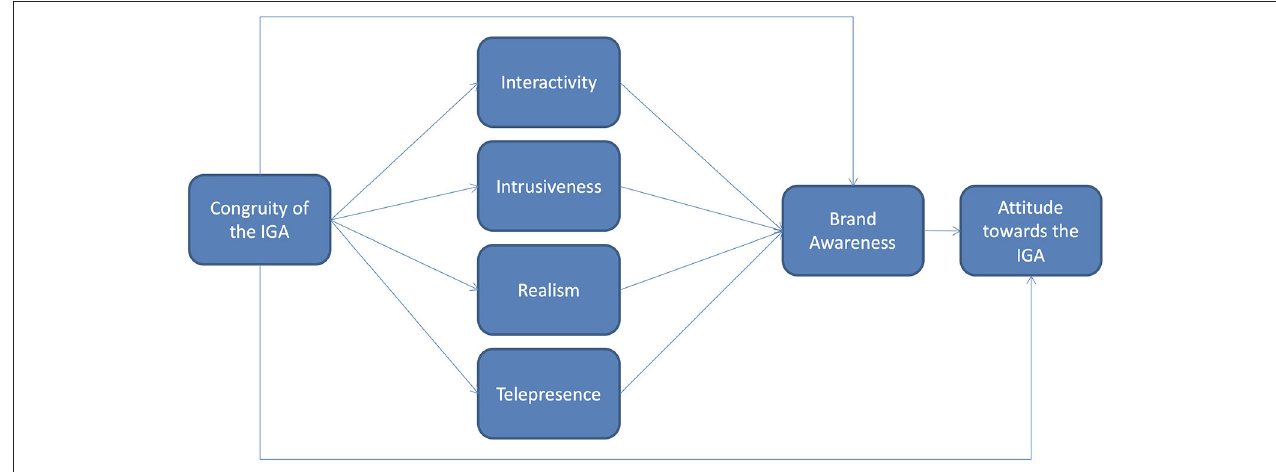
FIGURE 1 | VR in-game advertising congruity